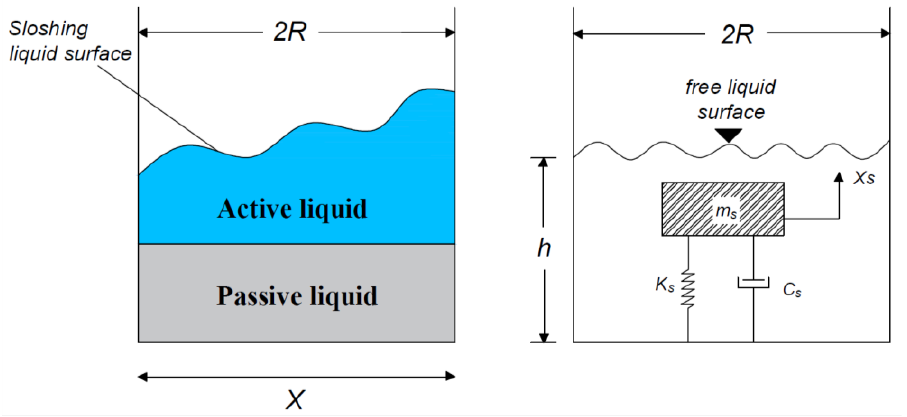
Figure 2. Cylindrical TLD sloshing model.